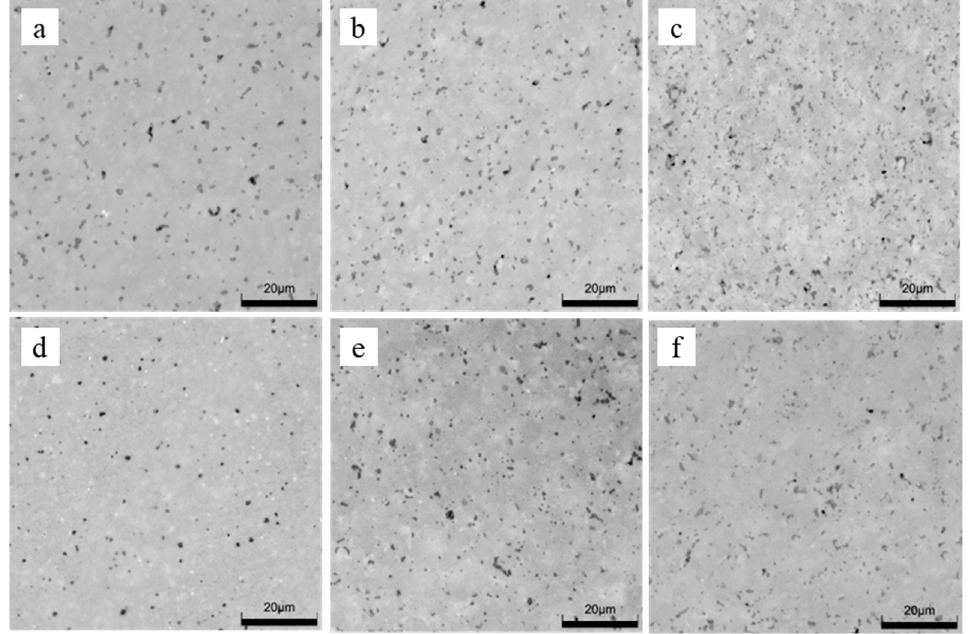
Figure 1. Optical microstructure of ( a – c ) 3YSZ and ( d – f ) 6YSZ ceramics sintered at ( a , d ) 1550, ( b , e ) 1500, and ( c , f ) 1450 °C.